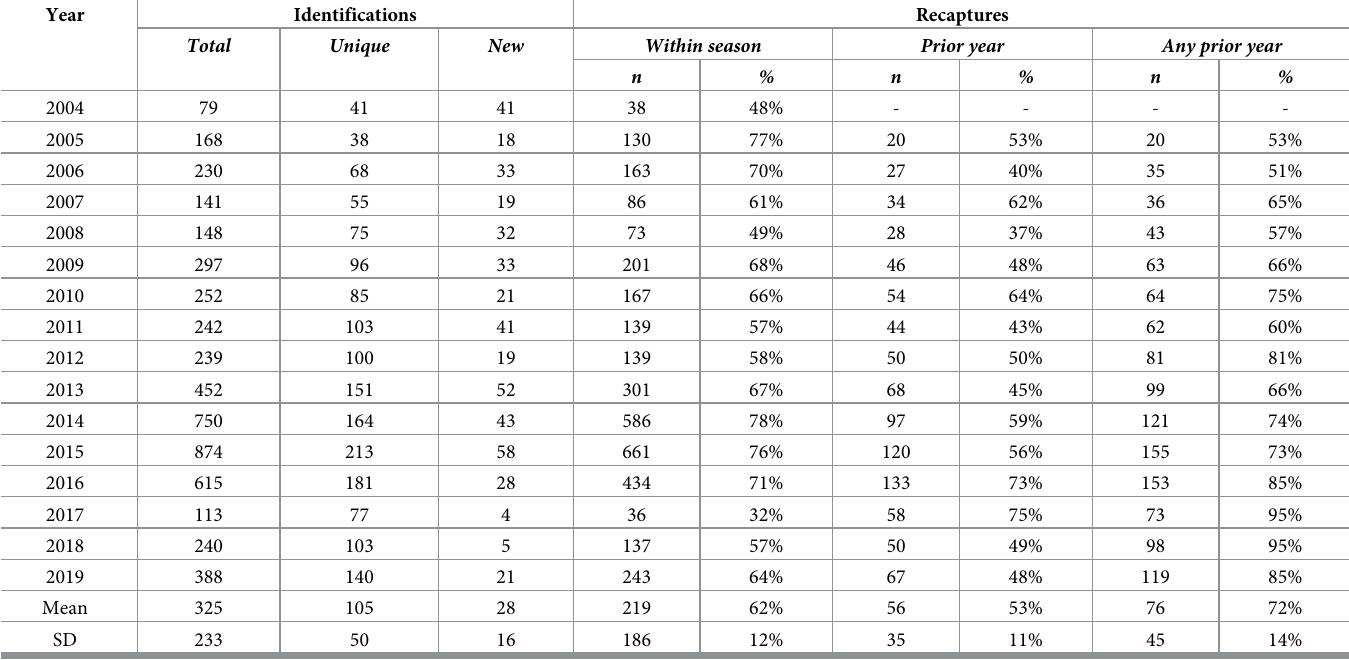
Table 1. Capture history of humpback whales in the Kitimat Fjord System,